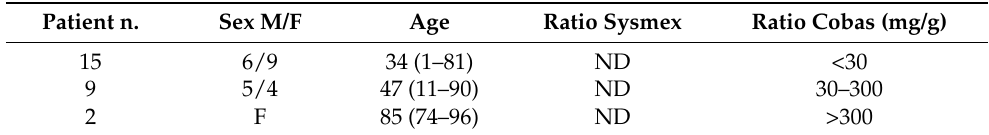
Table 2. In 26 patients, the semi-quantitative method (Sysmex UC 3500) with a urinary dipstick was not able to detect the ACR, while the quantitative test (Cobas C 501) successfully detected all the